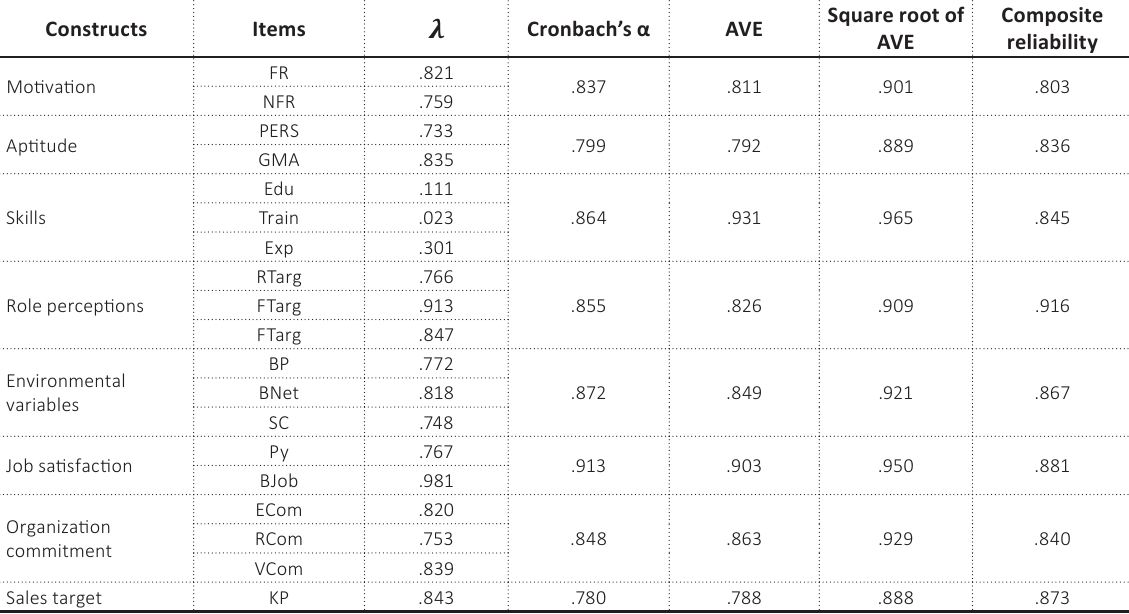
Table 3. Factor loadings